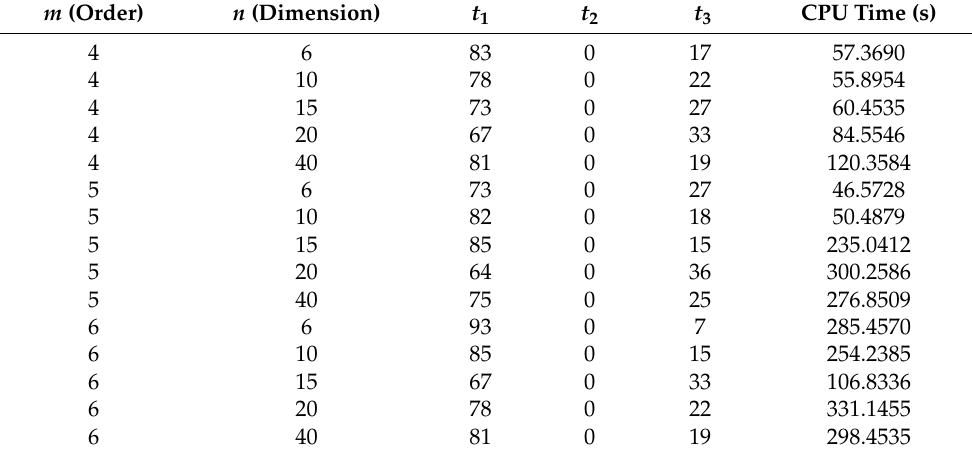
Table 1. Numerical results of Example 2.